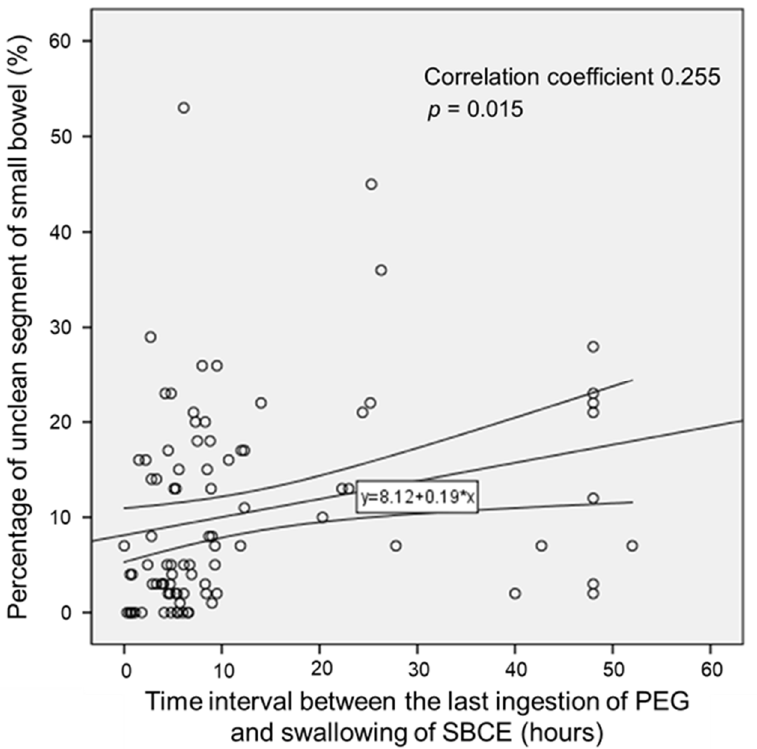
Figure 4. Correlation of the percentage of unclean segment of the small bowel with time interval be- tween the last ingestion of polyethylene glycol and swallowing of the small bowel capsule